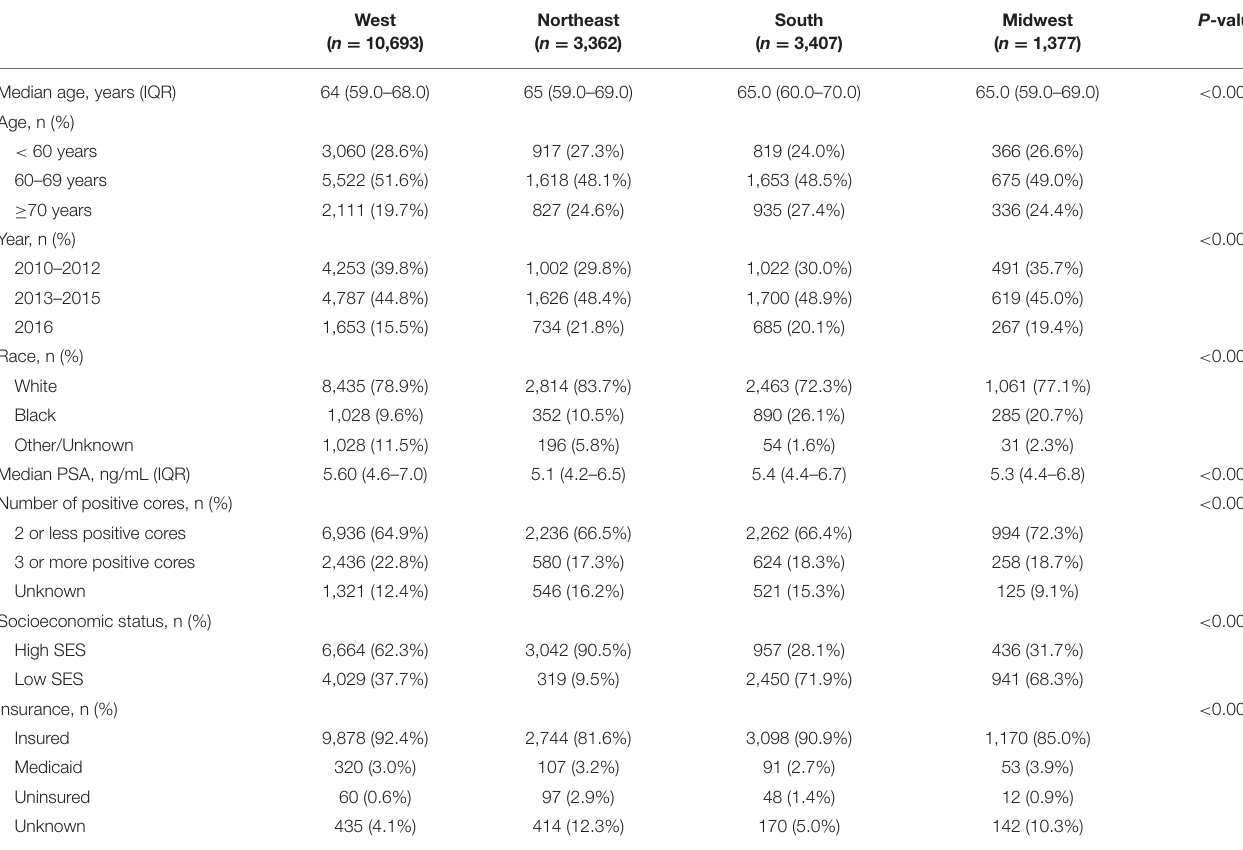
TABLE 2 | Characteristics of men managed with active surveillance in each US census region between 2010 and